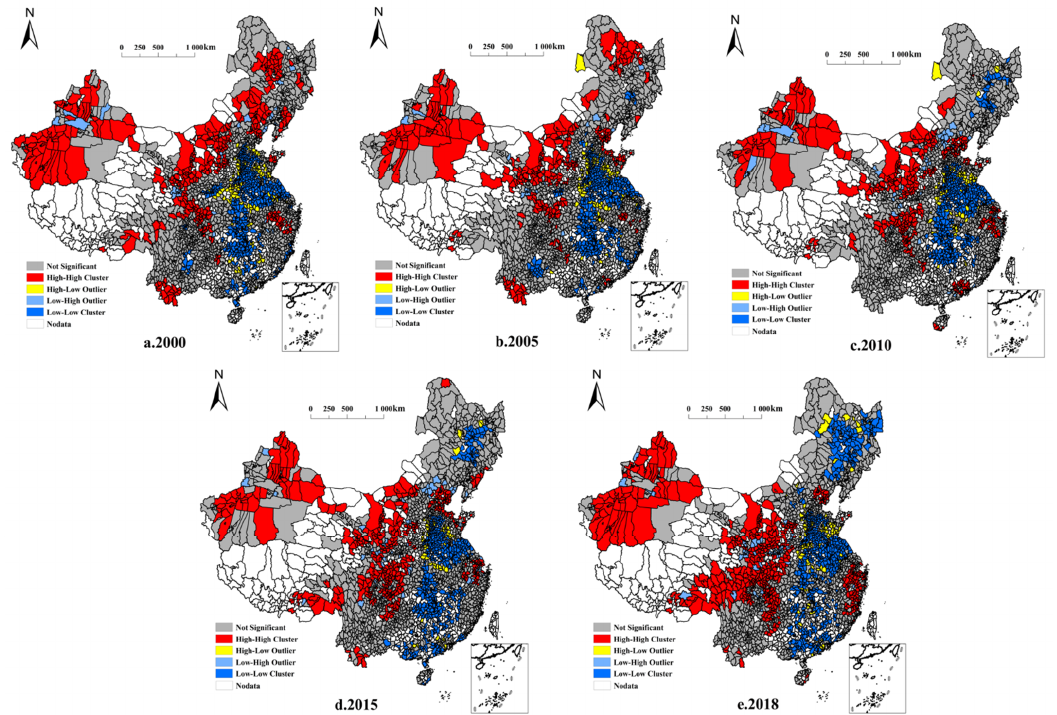
Figure 3. Local indicator of spatial association (LISA) cluster distribution map.